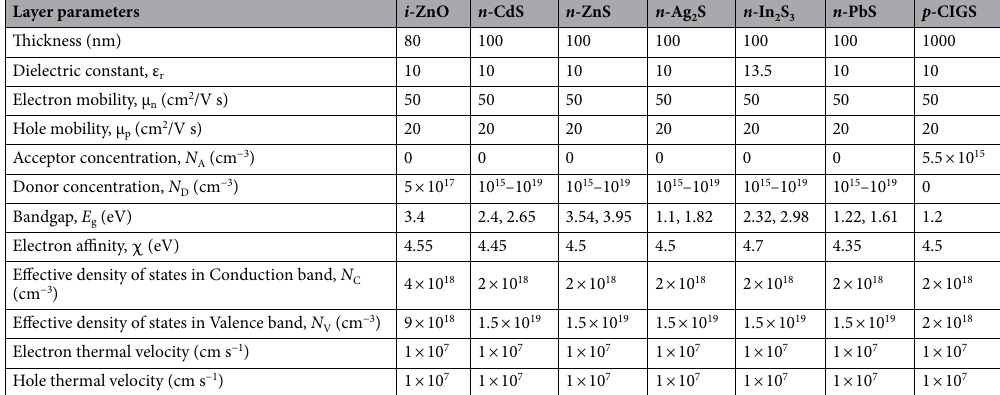
Table 1. List of physical and electronic properties for each layer parameter 15,17,18,32–40 .